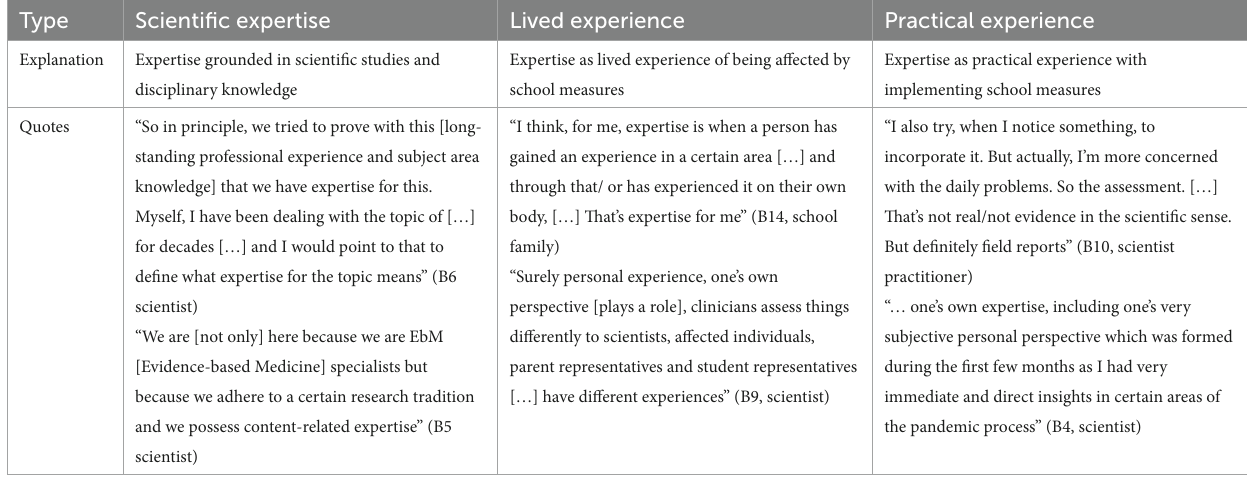
TABLE 5 Sub-category “Characterisation and sources of expertise” containing the three notions of expertise present in the data with supporting quotes.